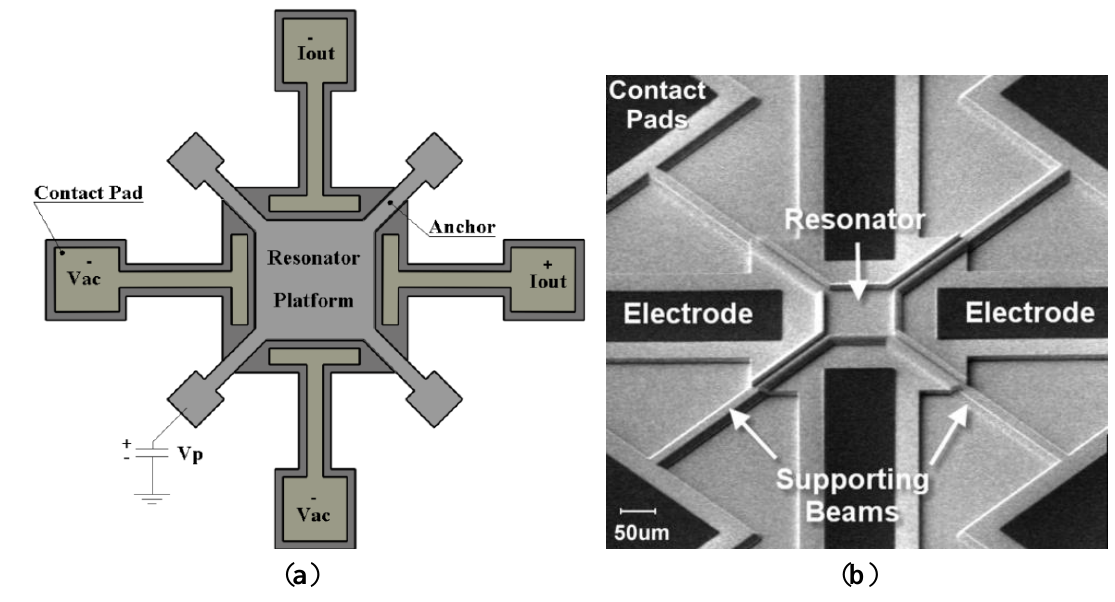
Figure 1. ( a ) Schematic of the device showing the resonator, exciting and sensing electrodes, driving and biasing setup ( b ) SEM microgrpagh of the fabricated mass sensor, silicon resonator, support beams and its surrounding polysilicon